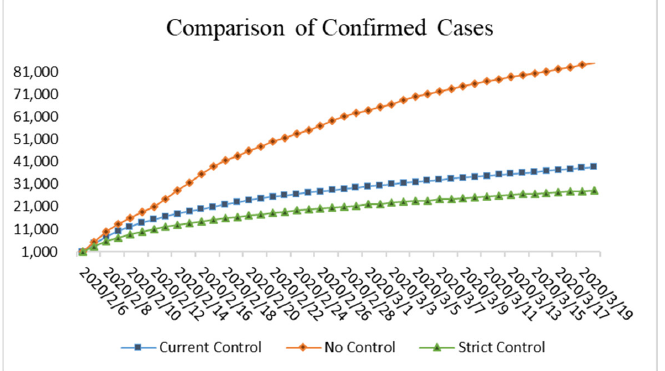
Figure 12. Comparison of partially confirmed patients under the above three